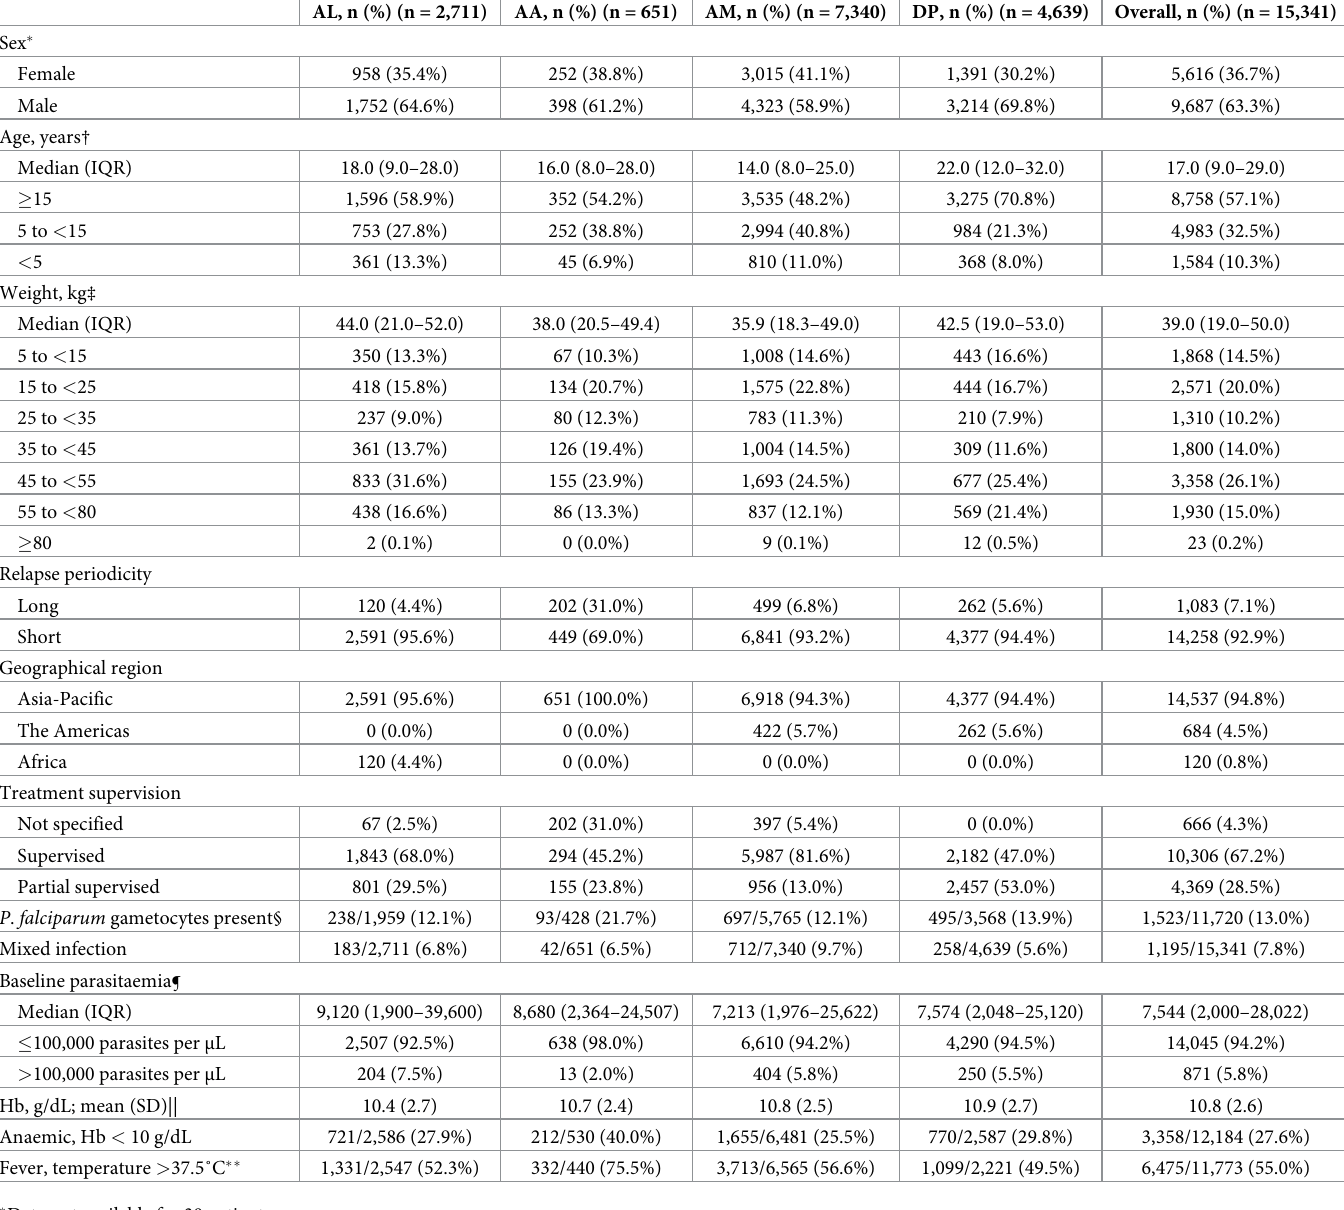
Table 1. Demographics and baseline